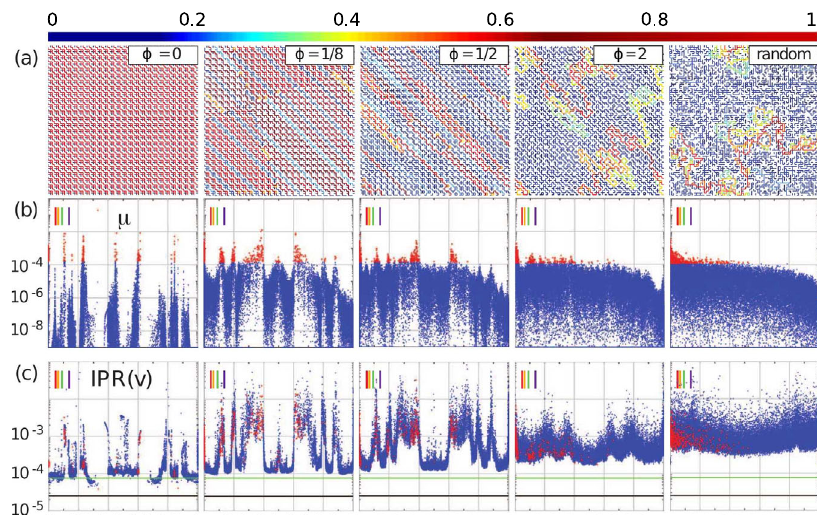
ffiffiffiffiffi p = 3, and square system of 10